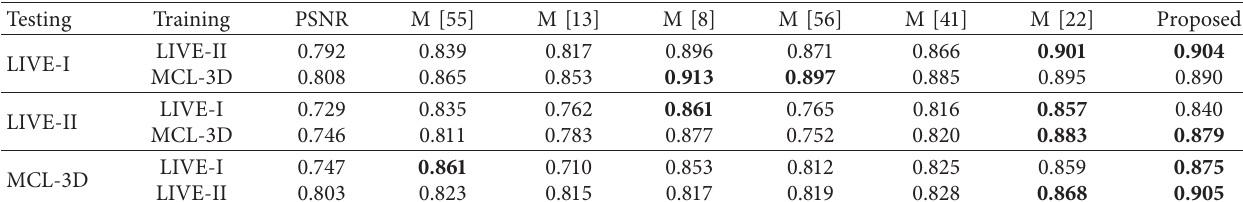
Table 7: SRCC comparison with other related methods for cross-database performance evaluation.